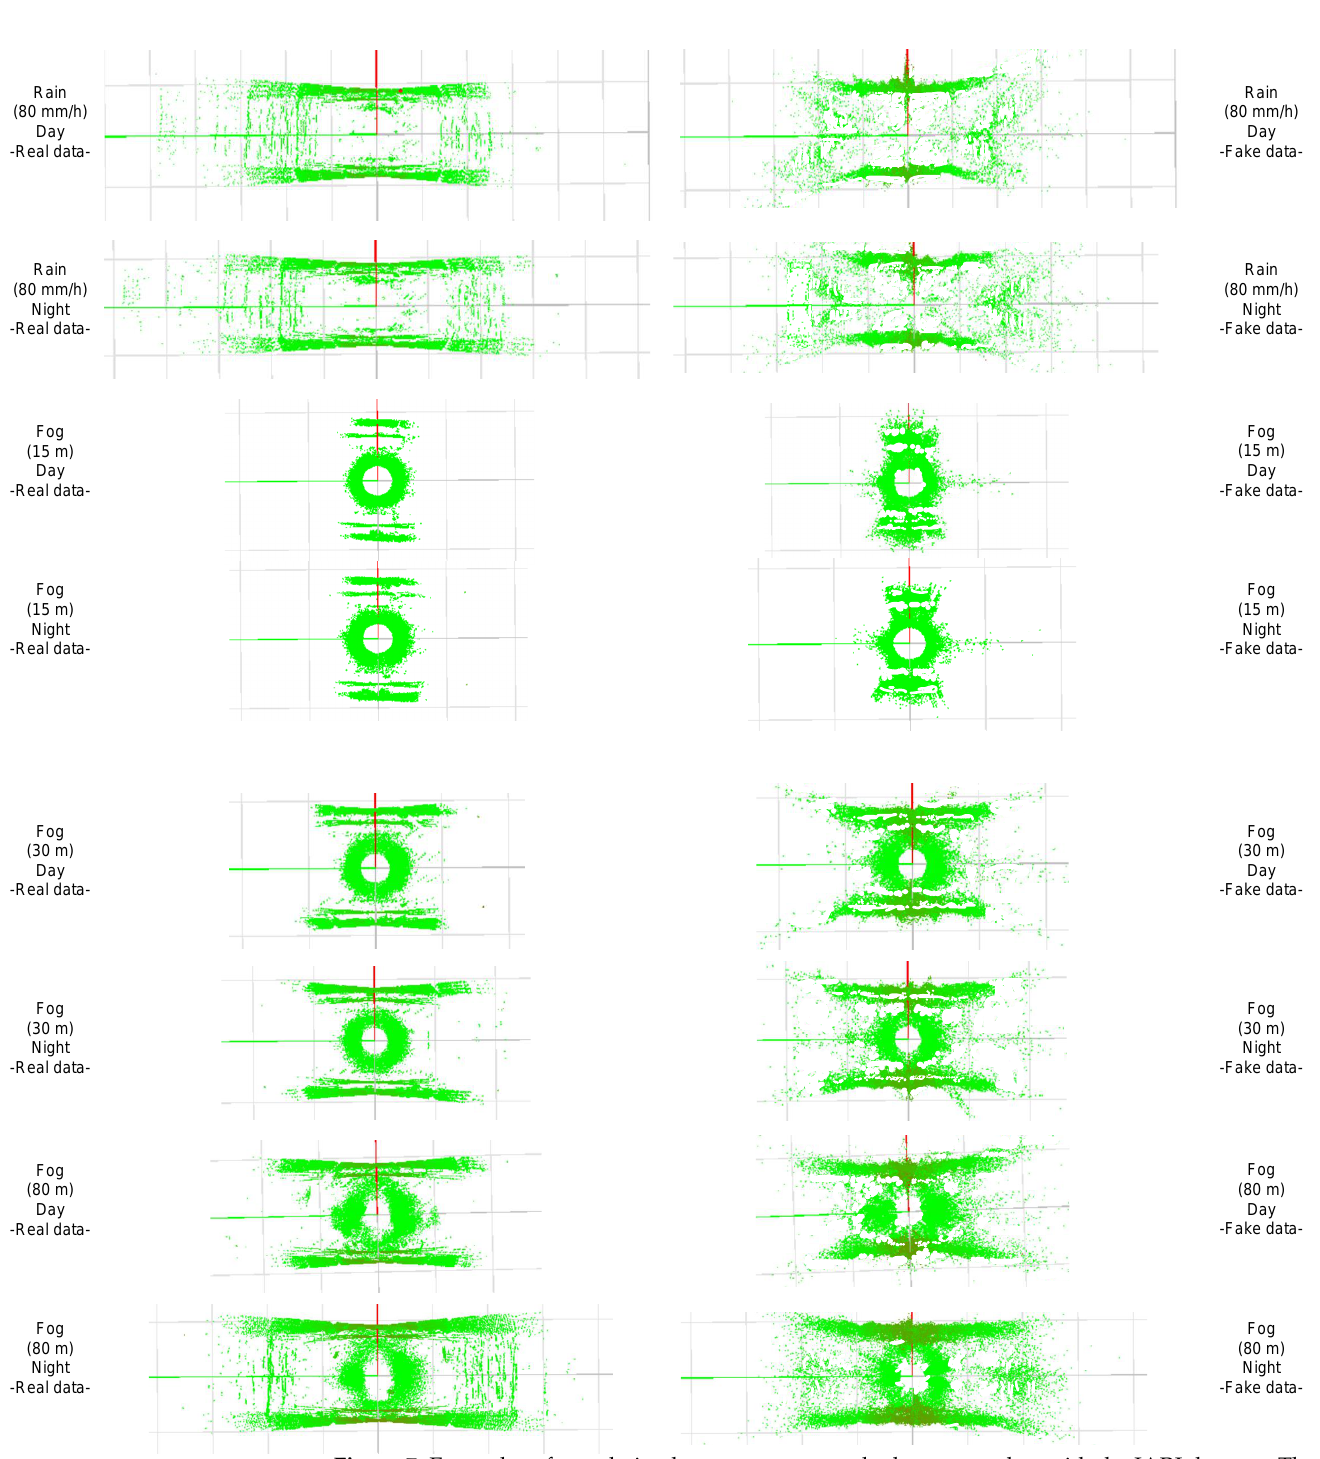
Figure 7. Examples of translation between sunny and adverse weather with the JARI data set. The results are reconstructed 3D points seen from above. The green points indicate reconstructed 3D points. The red points indicate the comparatively high value of intensity. We show the translation results between rainy and foggy conditions. The images on the left are the real data for the source domains, while those on the right are the generated data for the target domains. Even though there was some noise in the generated data, the proposed method can reflect the changes according to various environmental